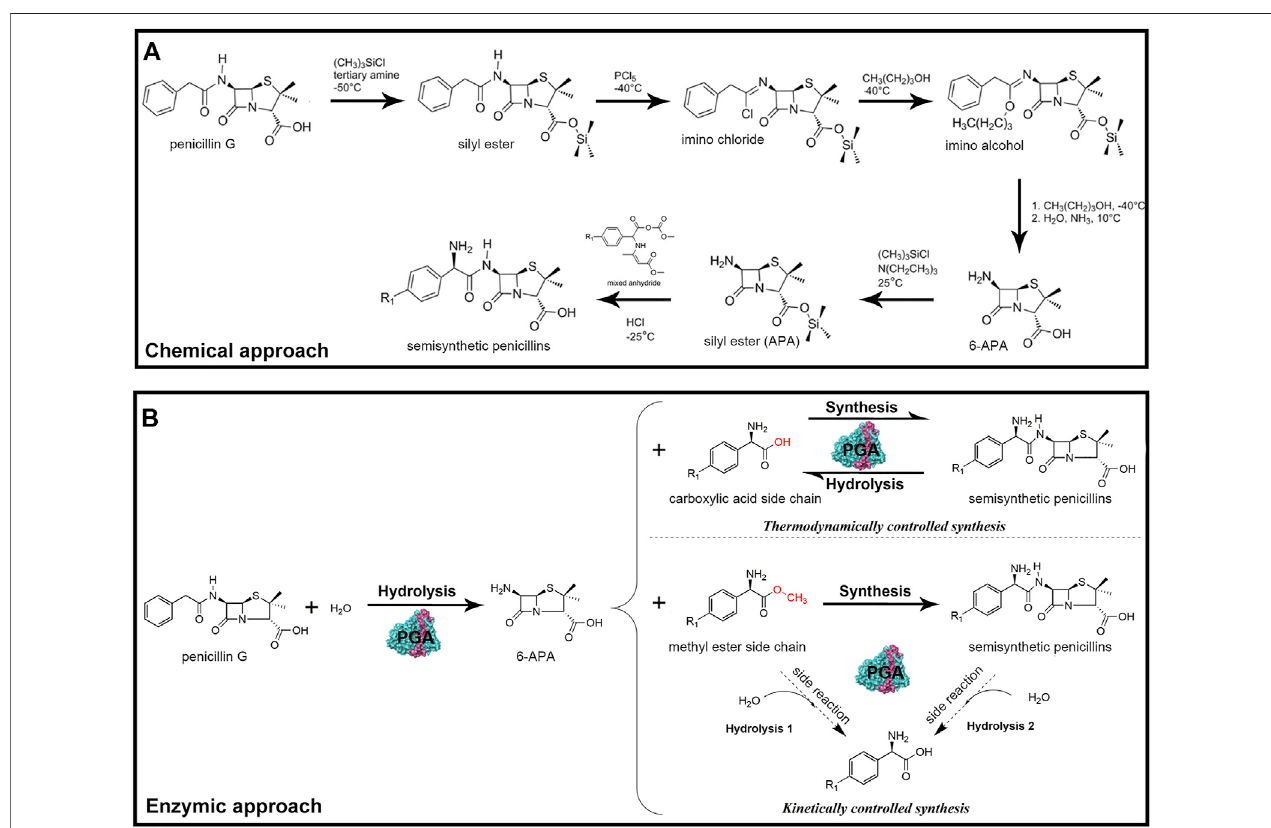
FIGURE 1 | (A) Traditional chemical synthesis of β -lactam antibiotics. (B) Enzymatic synthesis of β -lactam antibiotics by PGA. PGA fi rst deacylates penicillin G to produce key antibiotic nucleus 6-APA. Subsequently, PGA catalyzes the condensation of the nucleus and the acyl donor under thermodynamic or kinetic control, resulting in the generation of a series of semisynthetic